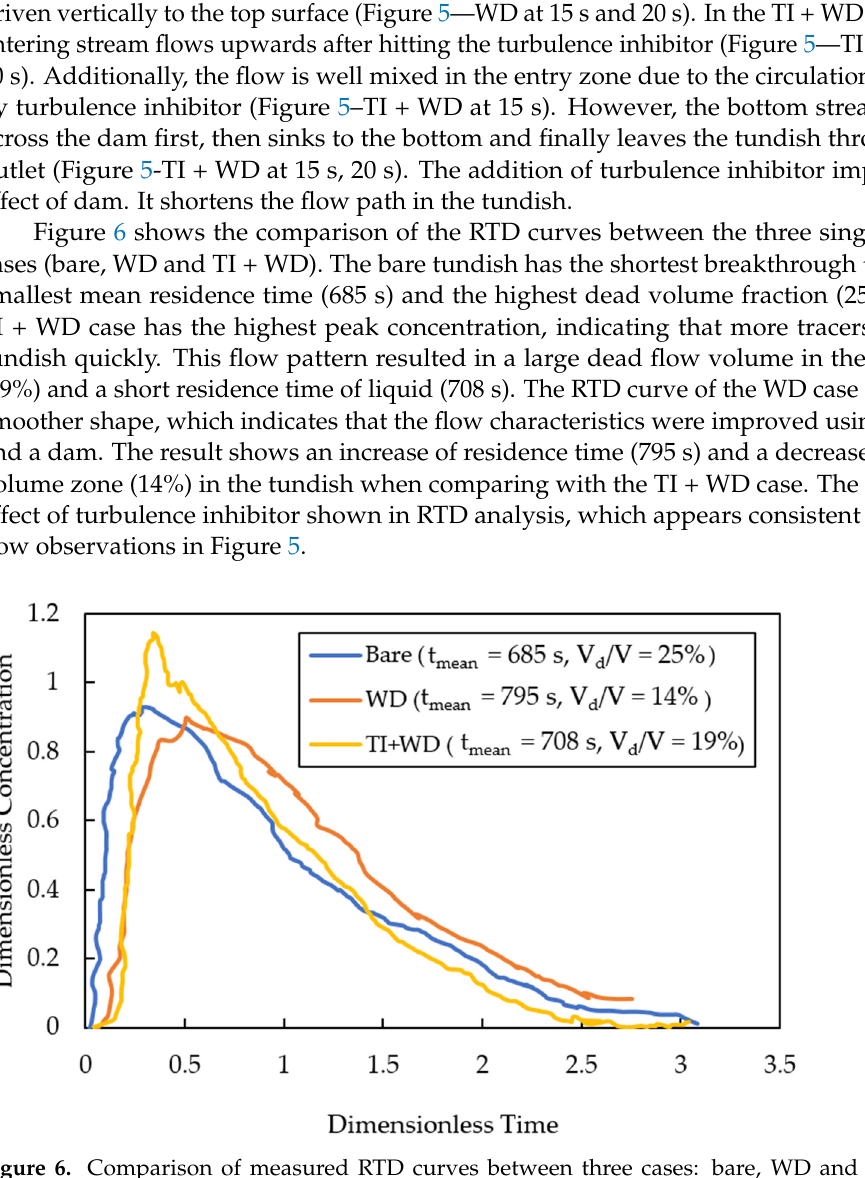
Figure 7. Tracer dispersion in cases of WG and TI + WG at 10 s, 15 s and 20 s in water experiments. Figure 8 shows the comparison of RTD curves between the two multiphase cases (WG and TI + WG). The TI + WG case has a longer mean residence time (796 s) and a lower dead volume fraction (9%) when comparing with the WG case. The RTD curve of the TI + WG case reveals the prolonged breakthrough and peak concentration time, indicating an improved performance in inclusion removal. The positive effect of the turbulence inhibi- tor is observed in the RTD analysis, which appears consistent with the flow observations in Figure 7.